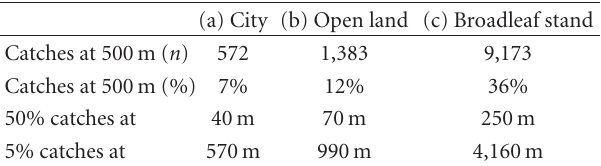
Table 1: Calculated values for the catches (beetles per trap) in (a) the city, (b) the open land, and (c) in the broadleaf stand